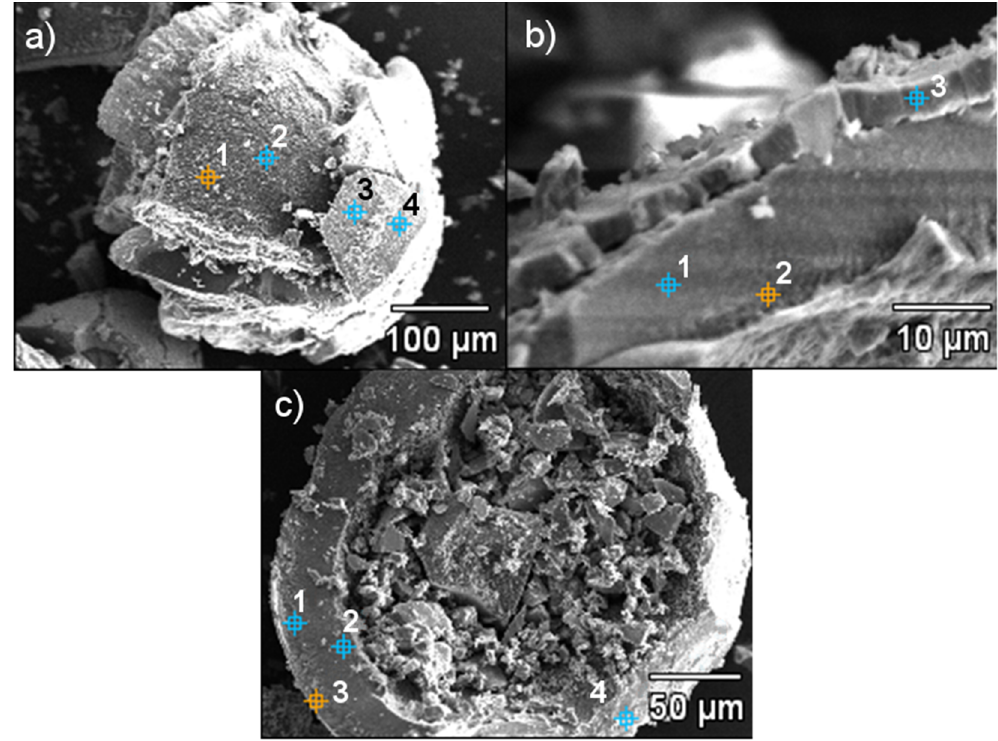
Figure 2. Areas of hybrid ion exchangers (HIX) examined using EDS point analysis: ( a , b ) CWM1#MnO 2 , ( c ) CWM3#MnO 2.